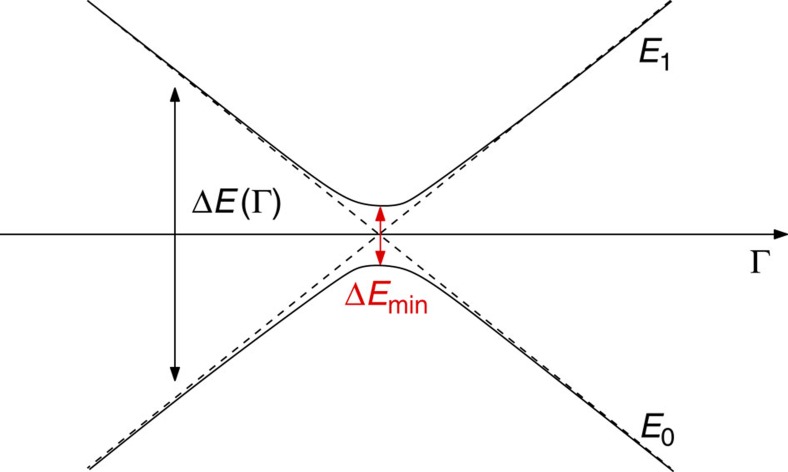
The two-level Landau–Zener model.A sketch of the behaviour of the two eigenenergies (E1, E2) as a function of some control parameter Γ. The gap ΔE=E2−E1 displays a pronounced minimum in correspondence of a given Γc value.